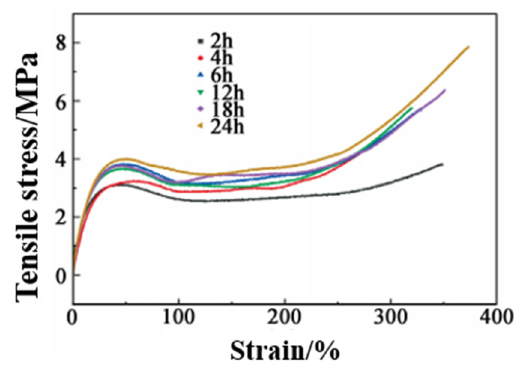
Figure 12. Tensile stress-strain curves of PUSS-6 after self-repair at different times. Table 5. Tensile strength and self-repair efficiency of PUSS-6 with different self-repair time. Tensile Strength/MPa Self-Healing Time/h Self-Healing Efficiency/%Original Sample Repaired